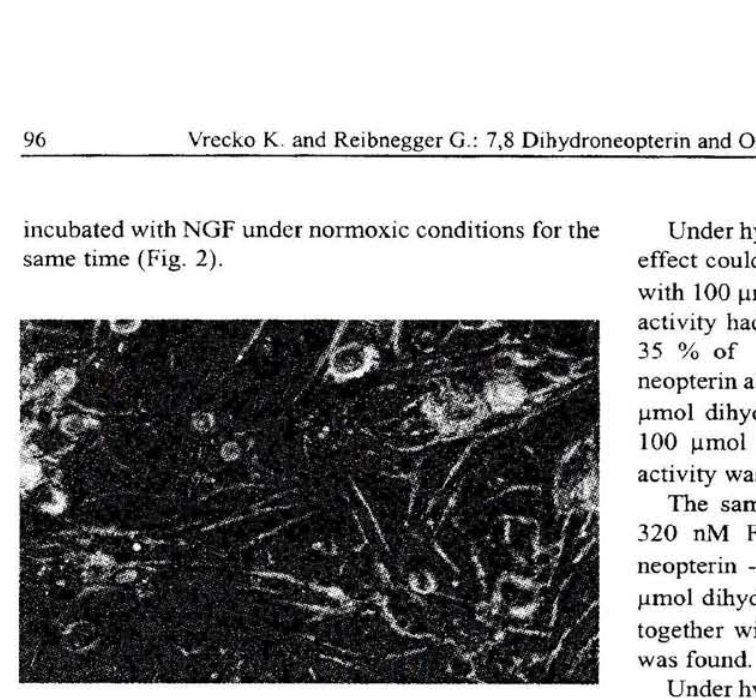
Figure 2. PC 12 cells after incubation under hyperoxic conditions (45 % N 2 , 5% CO z , 50% 0 2 ) for eight